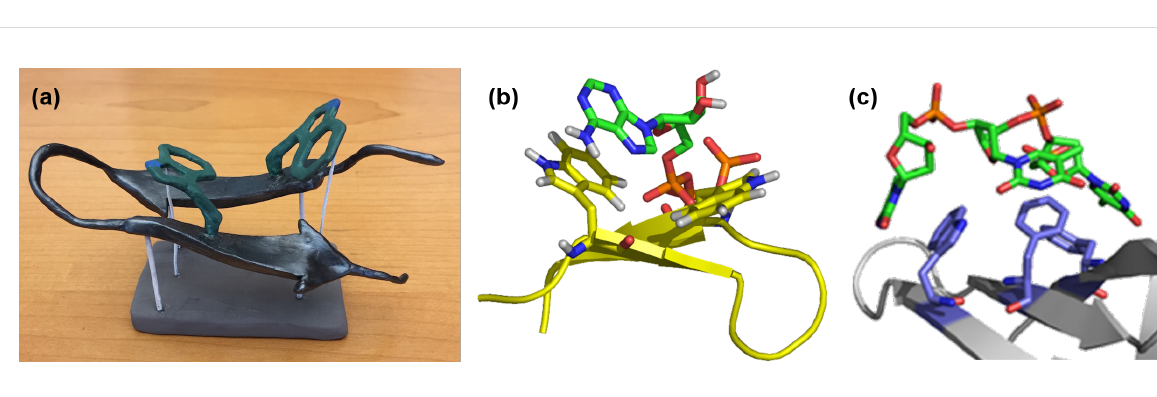
tion with KMe3 (trimethyllysine) and was the most stable β -hairpin reported at the time (after Robert Hughes) [22,23], and Alextide – for which folding can be turned on or off with post-translational modifications (after Alex Riemen)